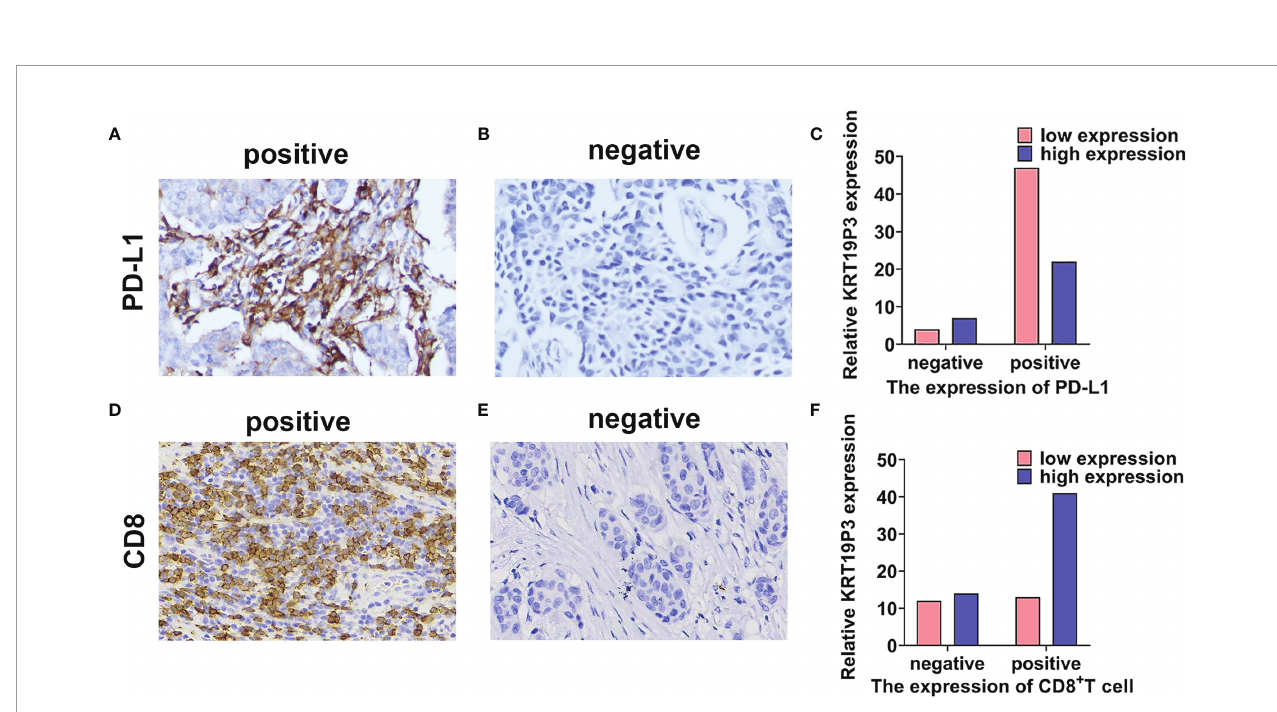
FIGURE 4 | LncRNA KRT19P3 correlated with PD-L1 and CD8 + T cell. (A, B) PD-L1 expression in breast cancer tissue ( A positive staining, 200x; B negative staining, 200x). (C) KRT19P3 expression was lower in the PD-L1-positive group than in the PD-L1-negative group in breast cancer tissues (n=80). (D, E) CD8 expression in breast cancer tissues ( D positive staining, 200x, E negative staining, 200x). (F) KRT19P3 expression was higher in the CD8 + T high group than in the CD8 + T cell low expression group in breast cancer tissues